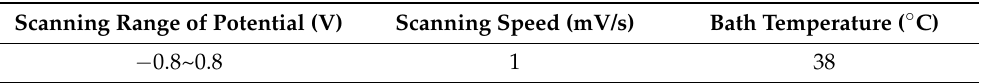
Figure 7. Schematic diagram of electrochemical corrosion test device. Table 4. Test parameters.